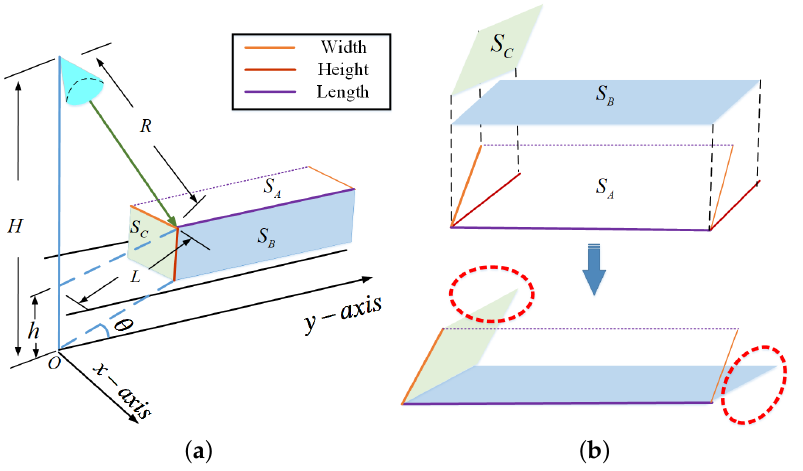
Figure 14. Vehicle 2D image mapping. ( a ) Radar detection geometry model. ( b ) Vehicle 2D